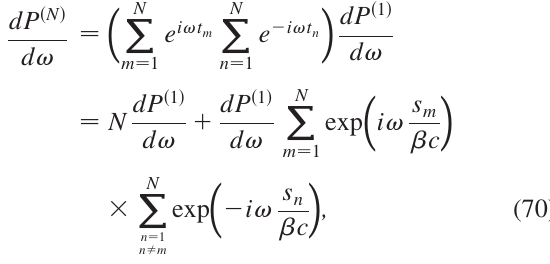
in which K is a modified Bessel function. The integral R